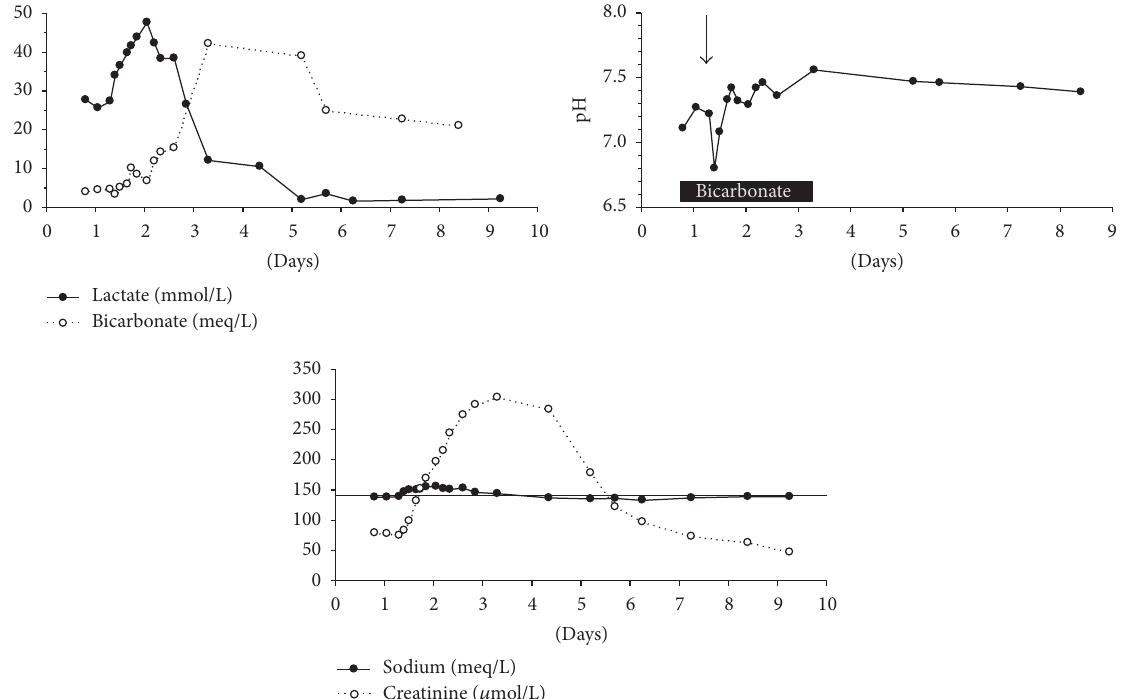
Figure 1: Changes in plasma pH and levels of lactate, bicarbonate, sodium, and creatinine during the hospitalization course. The black rectangle and arrow in the middle graph symbolize the period of bicarbonate infusion and the timing of initiation of mechanical ventilation, respectively. The horizontal line represents convenience sodium level of 140